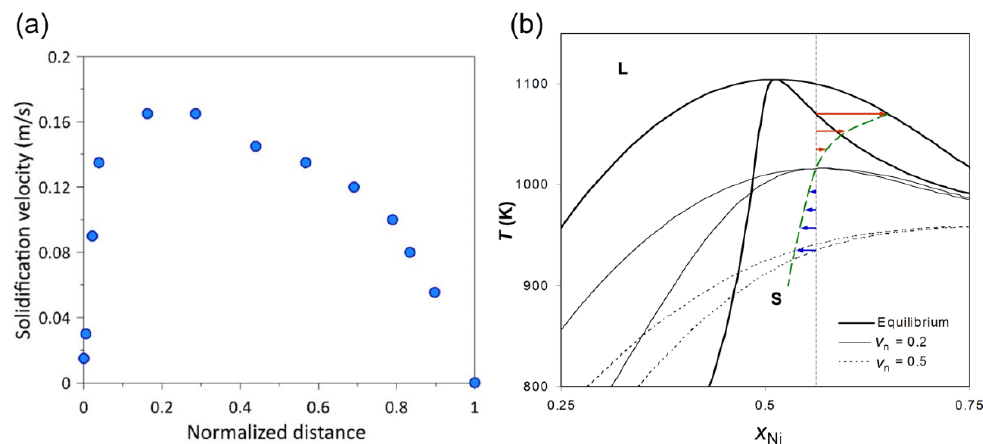
Figure 4. ( a ) Solidification velocity versus normalized distance from the bottom of the melt pool, calculated a system with x Al = 0.35 ( x Ni = 0.65) and v d = 0.2 m/s, and ( b ) schematic representation of the kinetic phase boundaries the B2 phase in a model system, indicating inversion of partitioning for an off-stoichiometric composition with increasing the normalised velocity ( v n = v / v d ) from 0 (equilibrium) to 0.5.